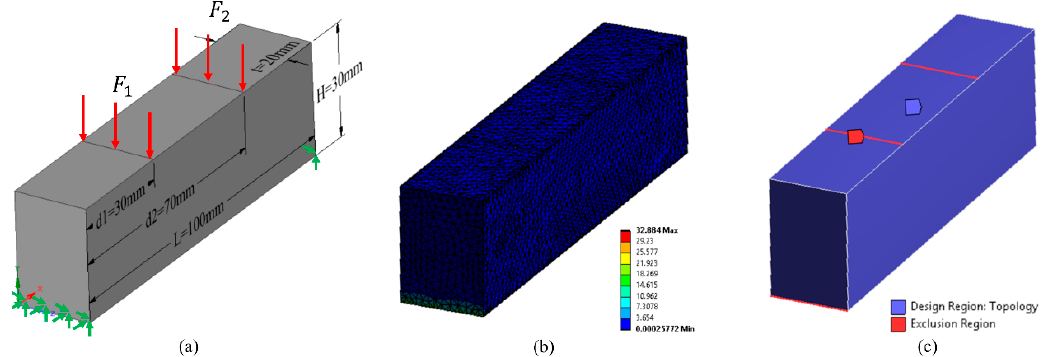
Figure 15. The design solutions of the L ‐